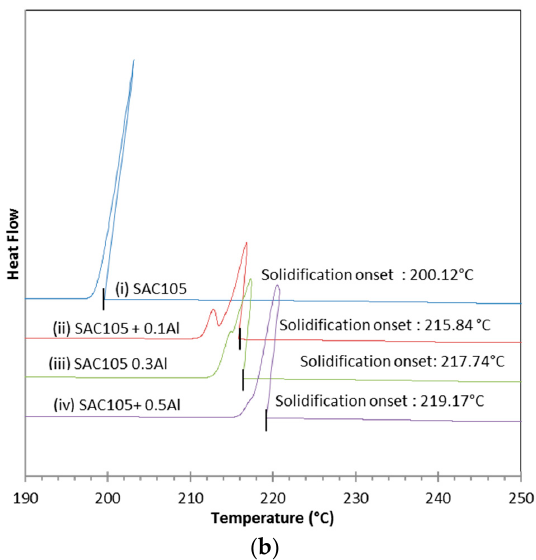
Figure 1. DSC curves for as cast SAC105, SAC105 + 0.1Al, SAC105 + 0.3Al and SAC105 + 0.5Al alloys: ( a ) heating; and ( b ) cooling.